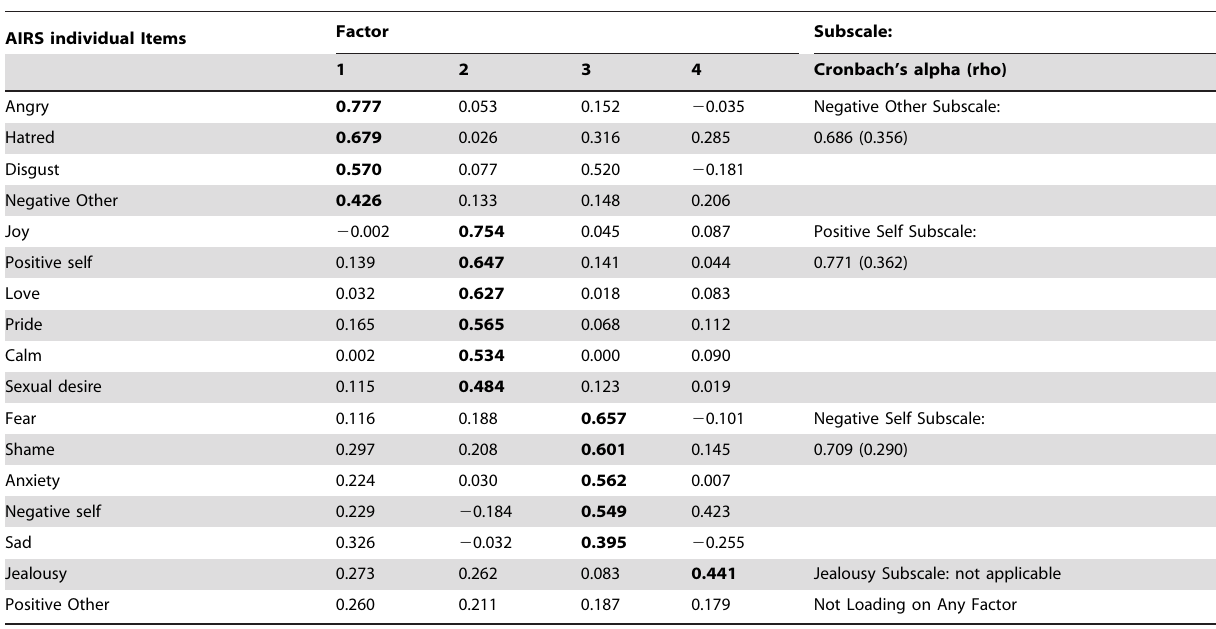
Table 4. Factor Analysis & Resulting